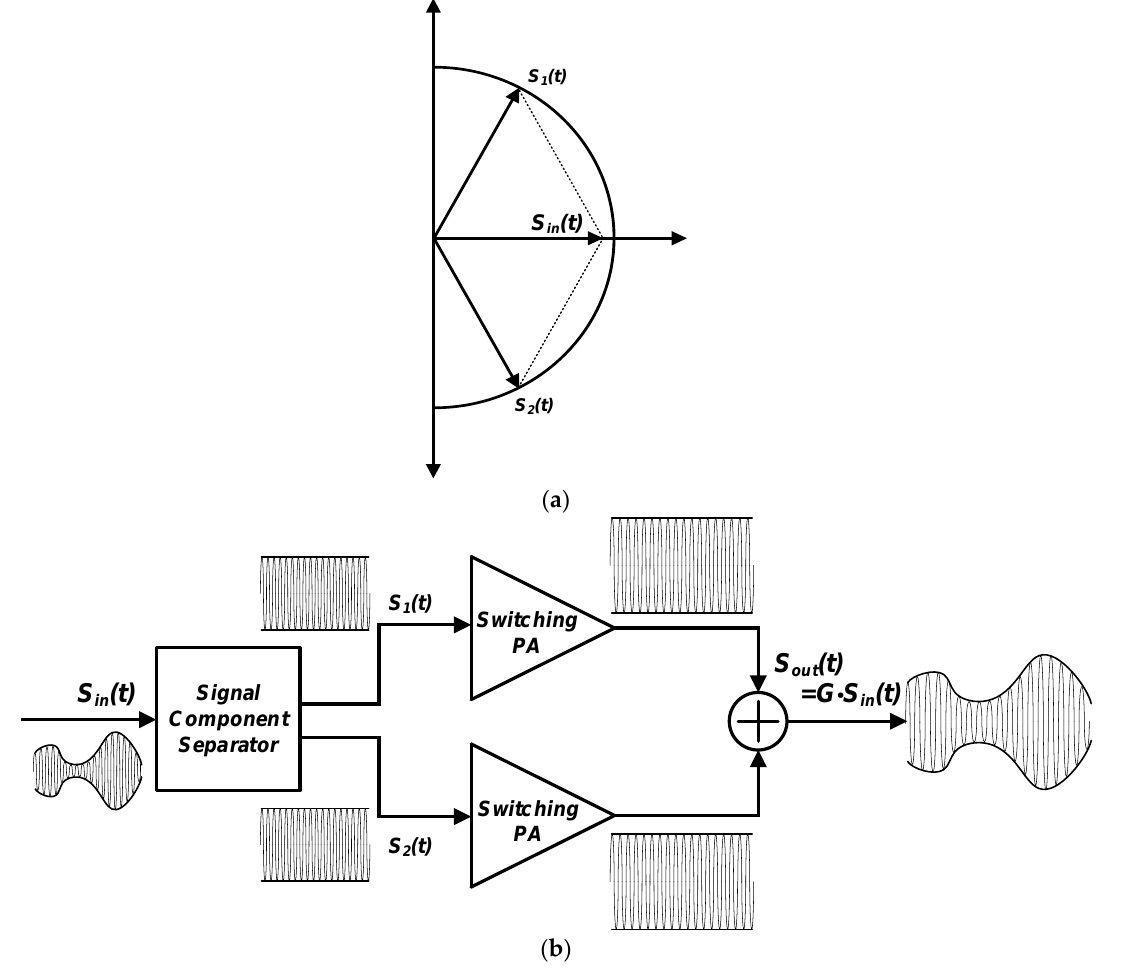
Figure 2. Outphasing principle and outphasing power amplifier (PA) architecture. ( a ) outphasing vector diagram, ( b ) outphasing architecture.